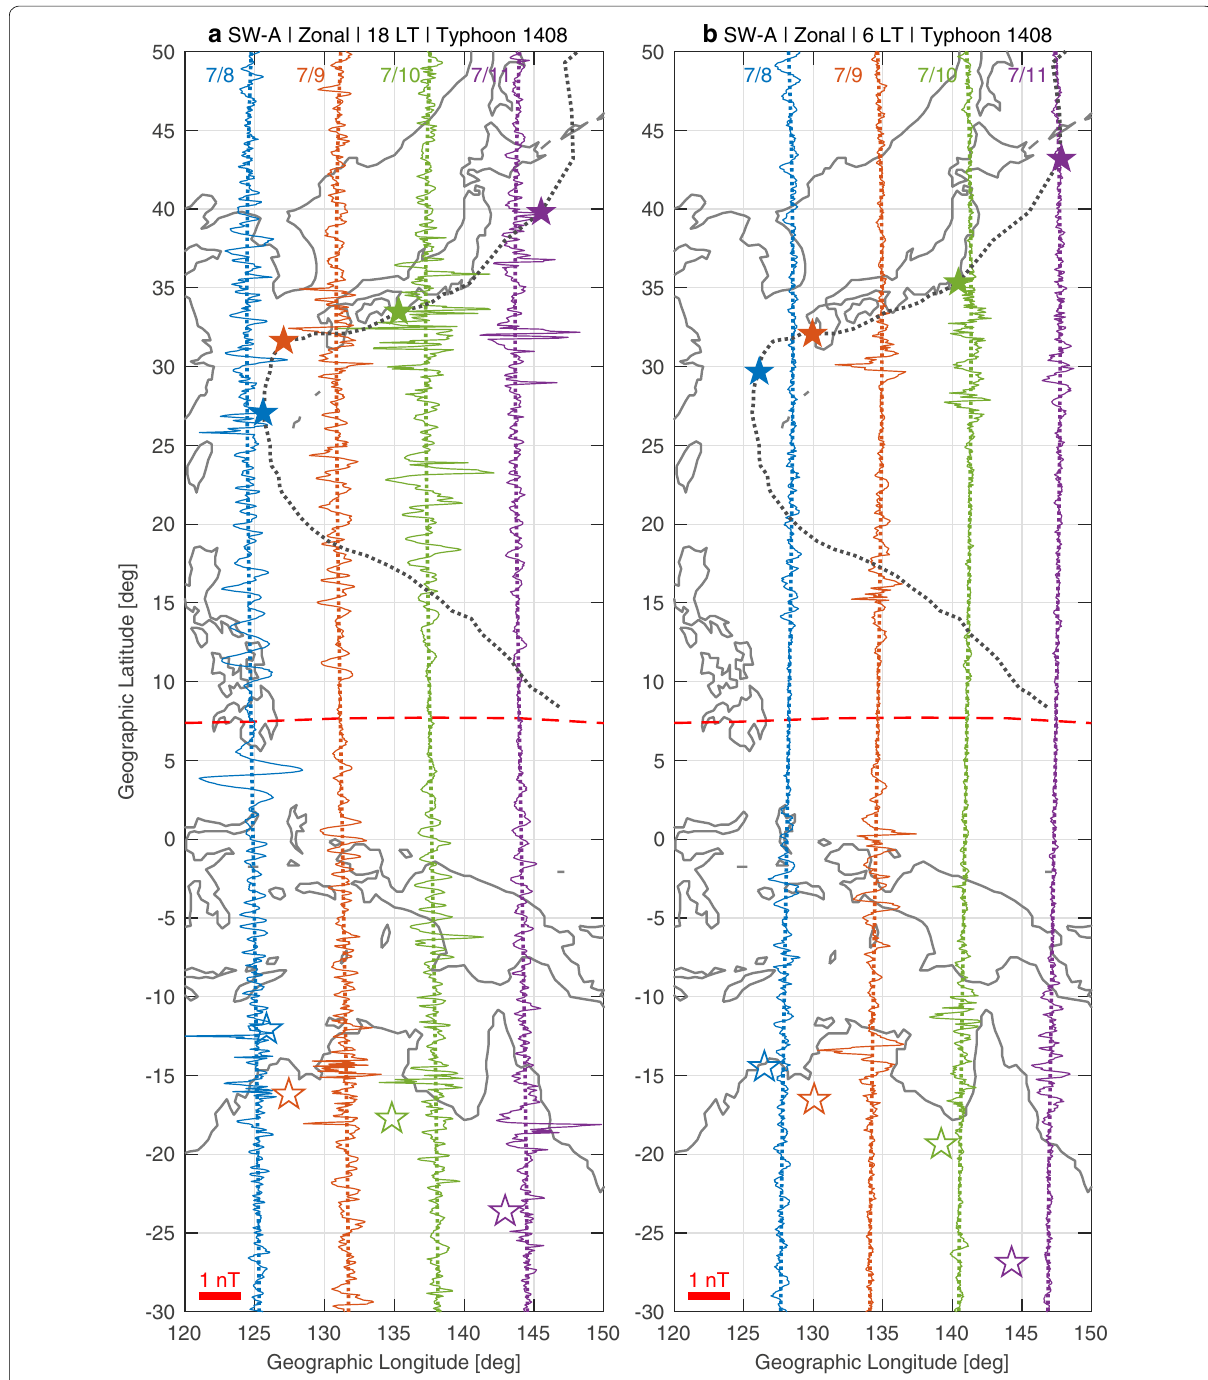
Fig. 7 MRs above typhoons as observed by SW-A. SW-A passed above the typhoon at a 18 LT and b 6 LT. Colored lines show the satellite orbit and zonal component of the magnetic fluctuations on each day; blue , orange , green , and purple correspond to July 8, 9, 10, and 11, 2014. Stars, dotted gray lines , and red lines indicate the location of the typhoon on each day, typhoon track, and dip equator. The colors of the stars correspond to the orbit with the same color . Stars in the southern hemisphere indicate the magnetic conjugated point of the location of the